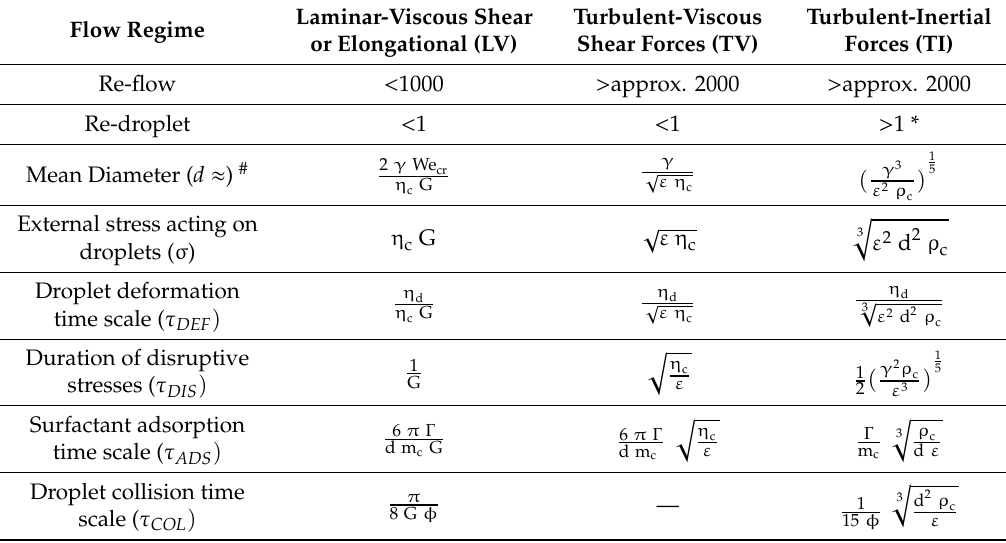
Table 2. Summary of equations for estimating expected mean droplet diameter, stresses exerted on droplets, and relative time scales in emulsification process under laminar and turbulent flow conditions [56]. Laminar-Viscous Shear Turbulent-Viscous Flow Regime or Elongational (LV) Shear Forces